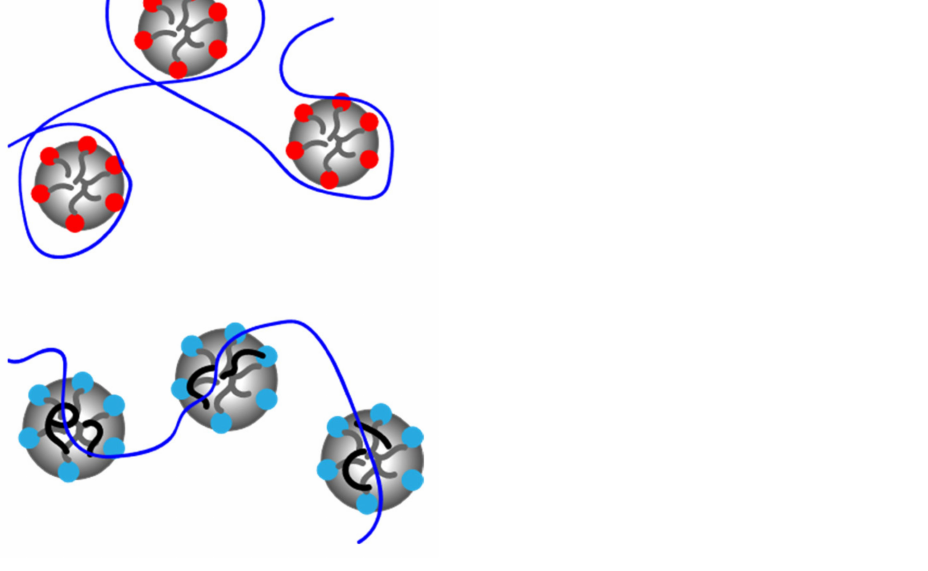
Figure 2. Graphical representation of PESCs of opposite sign charge ( top ) and same sign charge ( bottom